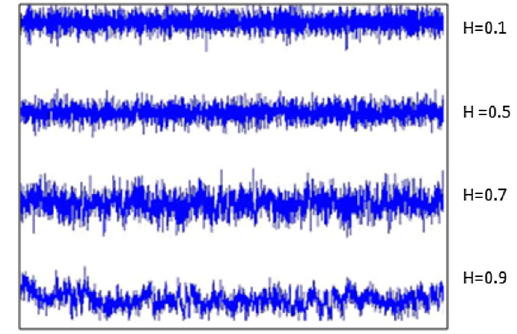
Fig. 3 Fractional Gaussian noise for different values of